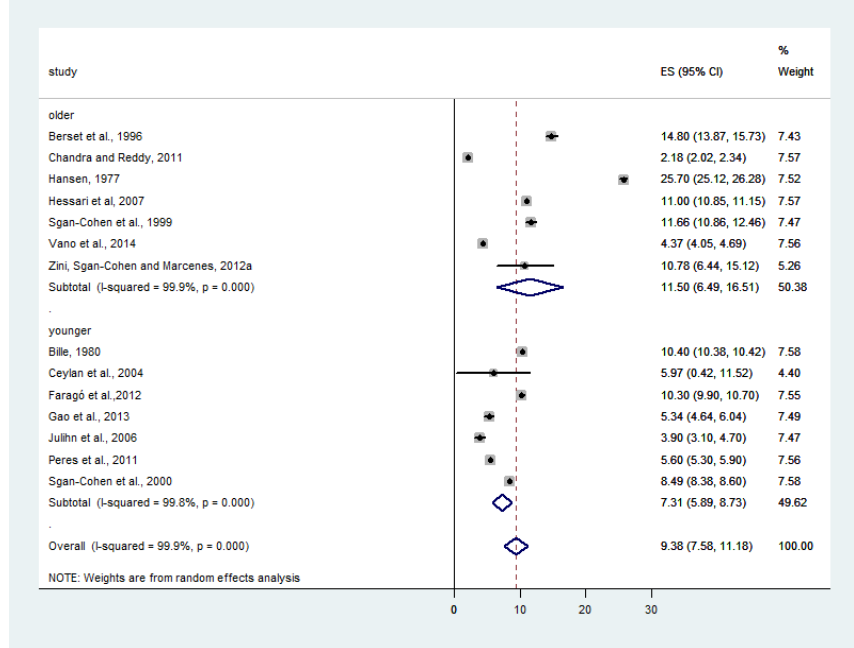
Figure 7. Association between ‘age’ and caries experience (DMFT). The pooled effect estimates from the random-effects meta-analysis are shown. Heterogeneity was assessed using the χ 2 test and I 2 statistics. The forest plots are comparing caries in studies with older population (>33.4 years) compared with studies with younger population ( ≤ 33.4 years)